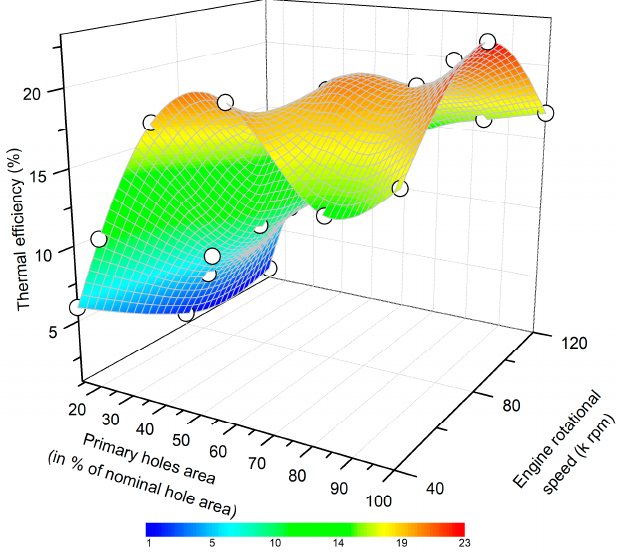
Figure 8. Impact of the primary zone air holes variable geometry on thermal efficiency.